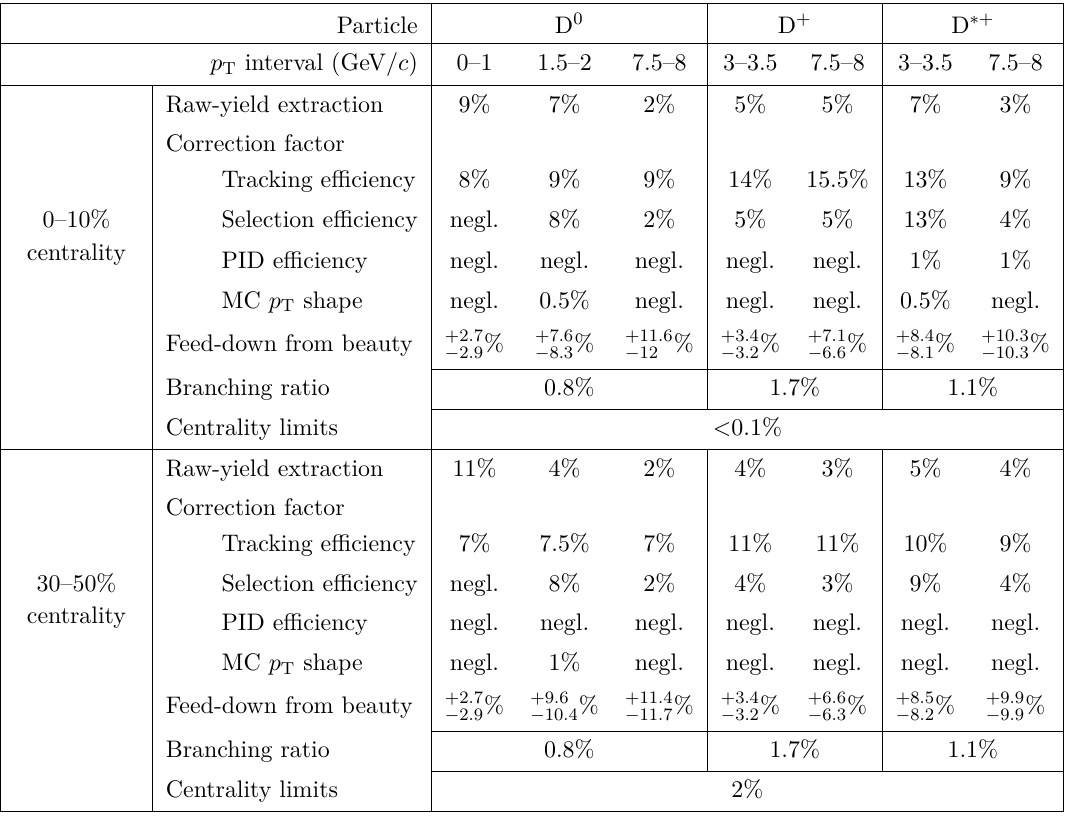
Table 2 . Relative systematic uncertainties on prompt D-meson yields in Pb–Pb collisions at √ s = 5 . 02 TeV for representative p T intervals. The first p T interval of the D 0 corresponds to NN the analysis without decay vertex reconstruction. For the uncertainties on the correction factors, values below 0.5% are considered